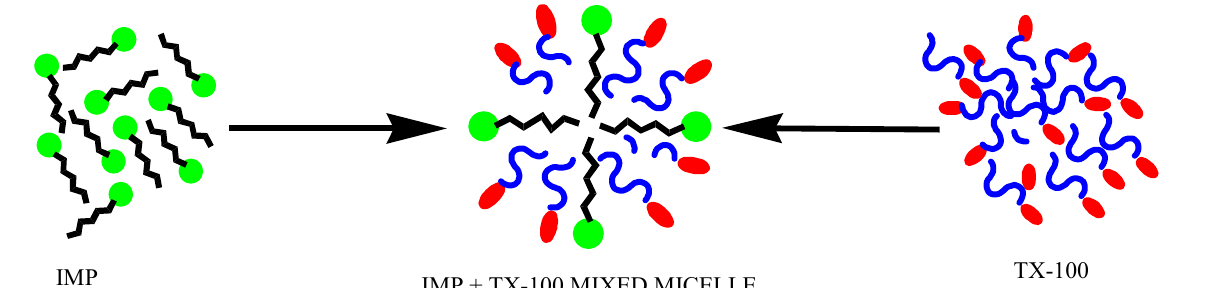
Scheme 1. Mixed micelle formation of the IMP+TX-100 mixed